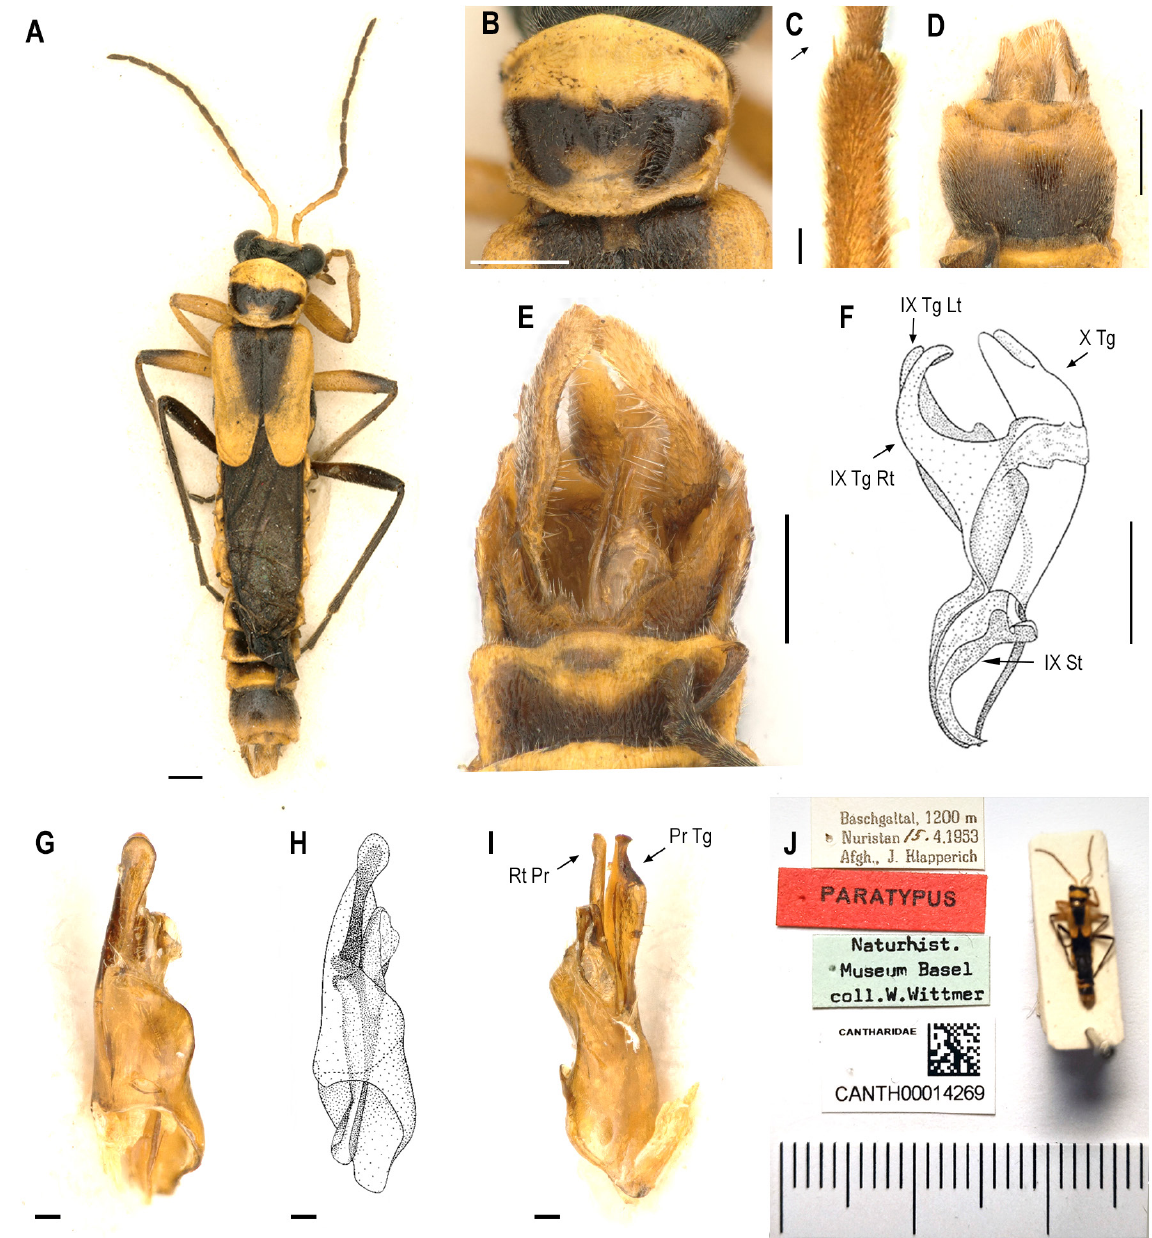
Fig. 6. Trypheridium nuristanicum (Wittmer, 1956) nom. emend., paratype, ♂ (CANTH00014269, NHMB). A . Dorsal habitus. B . Pronotum. C . Apex of fore tibia showing a pair of tiny spurs (arrow). D . Terminal segments, dorsal view. E . Terminal segments, ventral view. F . Terminal segments, lateral view. G–H . Aedeagus, lateral view. I . Aedeagus, ventral view. J . Paratype label. Abbreviations: IX St = sternite IX; IX Tg Lt = left blade of tergite IX; IX Tg Rt = right blade of tergite IX; X Tg = Tergite X; Pr Tg = prolongation of tegmen; Rt Pr = right paramere. Scale bars: A–B, D–F = 0.5 mm; C, G–I = 0.1 mm. Line drawings (F, H) adapted from Magis & Wittmer